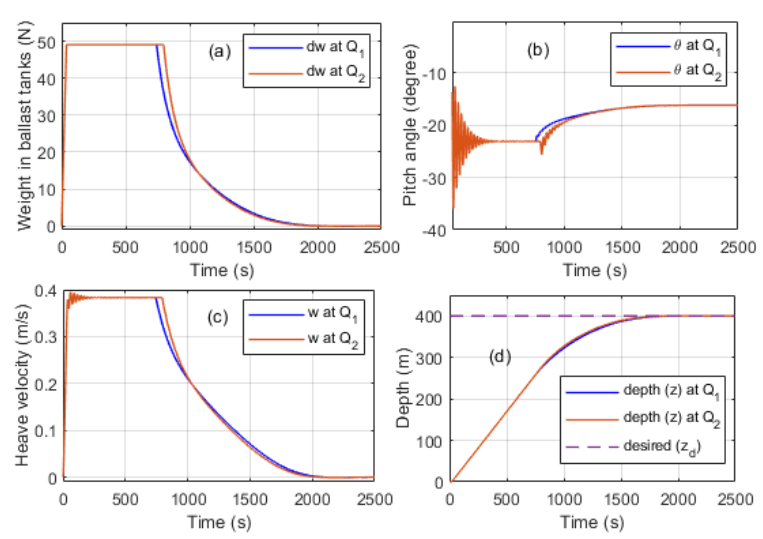
Figure 15. ( a ) Variation of the weight vs. time in ballast tanks, ( b ) pitch angle with time, ( c ) sinking (heave) velocity with time and ( d ) depth with time in closed loop for two different state weighing matrices.